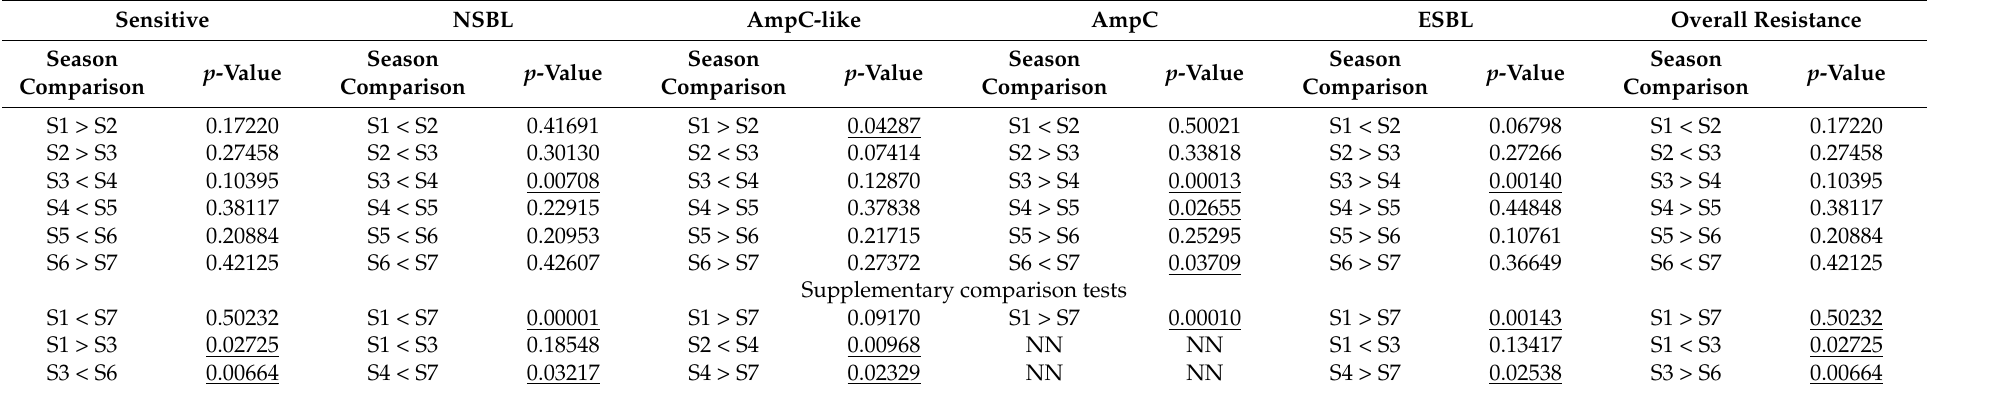
Table 3. Results of Fisher’s exact test ( p -value) for each resistance profile over the seven calving